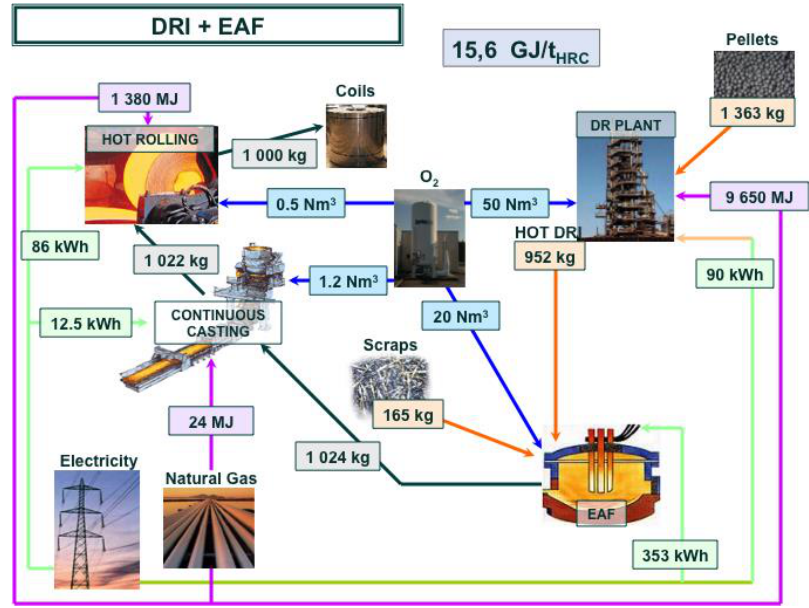
Figure 8. Mass and energy balance in an EAF-based steel mill fed with hot Direct Reduced Iron.